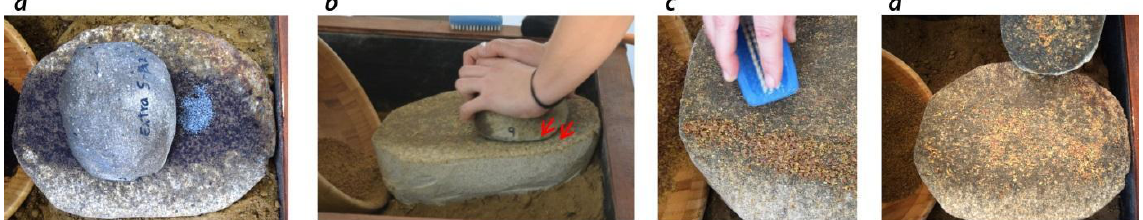
Figure 11. Experimental sequences. Experiment 2 grinding of poppy seed (a) and linseed (b). Note the sticky paste added to the surface during the oil seed processing